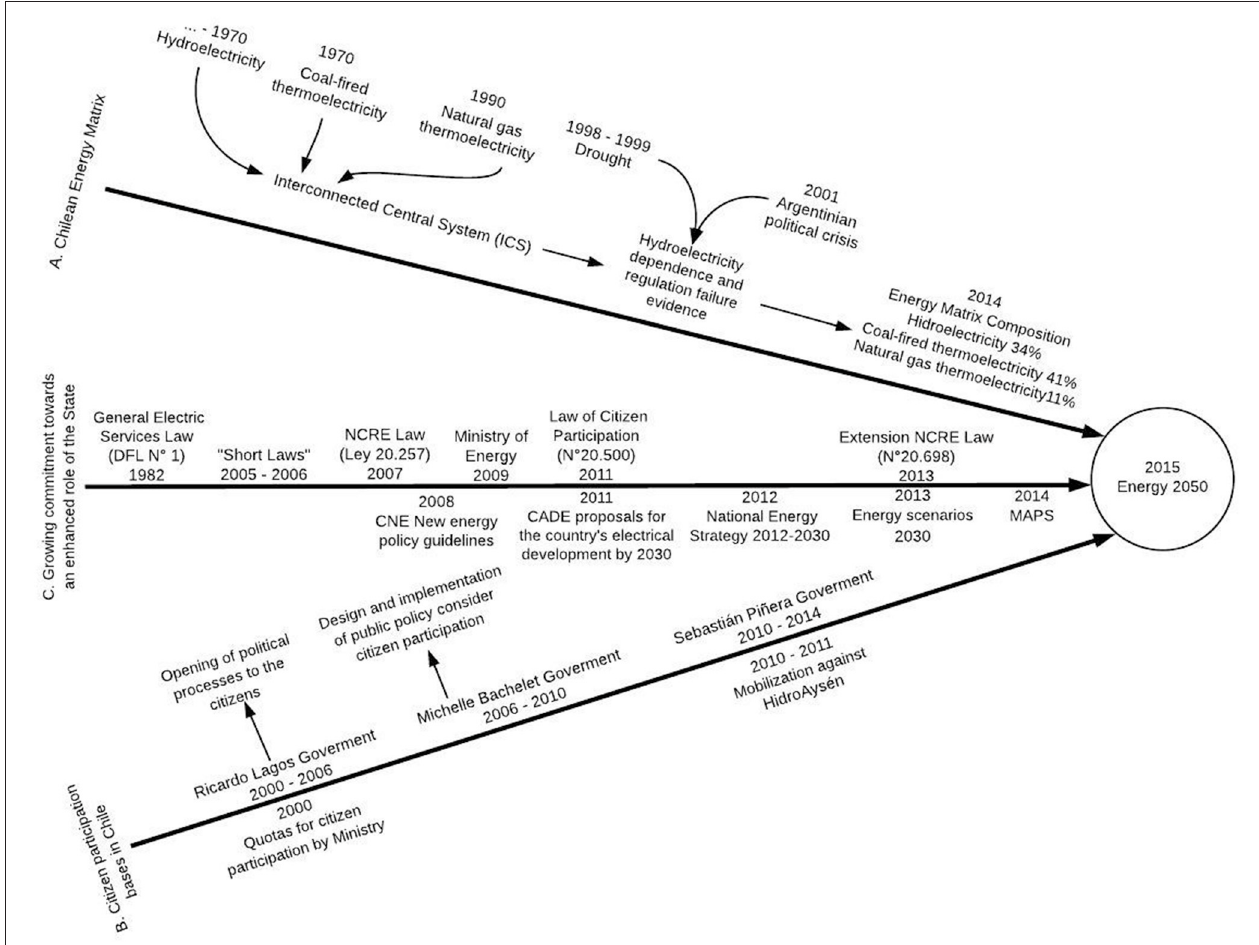
FIGURE 1 | E2050 historical